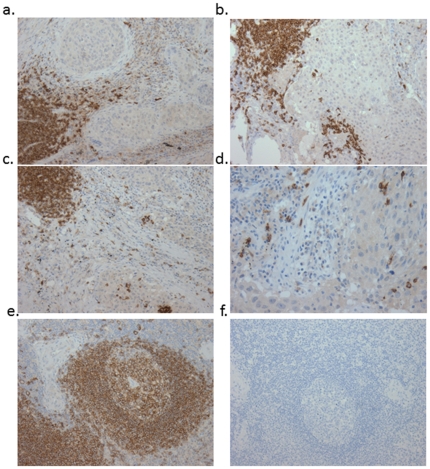
Representative CD20 immunohistochemistry in non-small cell lung cancer at 100×magnification.a and b. Tumor cells fail to stain; positivity seen only in stromal B-lymphocytes. c and d. Tumor cells again negative; CD20-positive B-cells infiltrating tumor nests and stroma. e. Positive control (reactive lymph node). f. Negative control (lymph node without primary antibody).